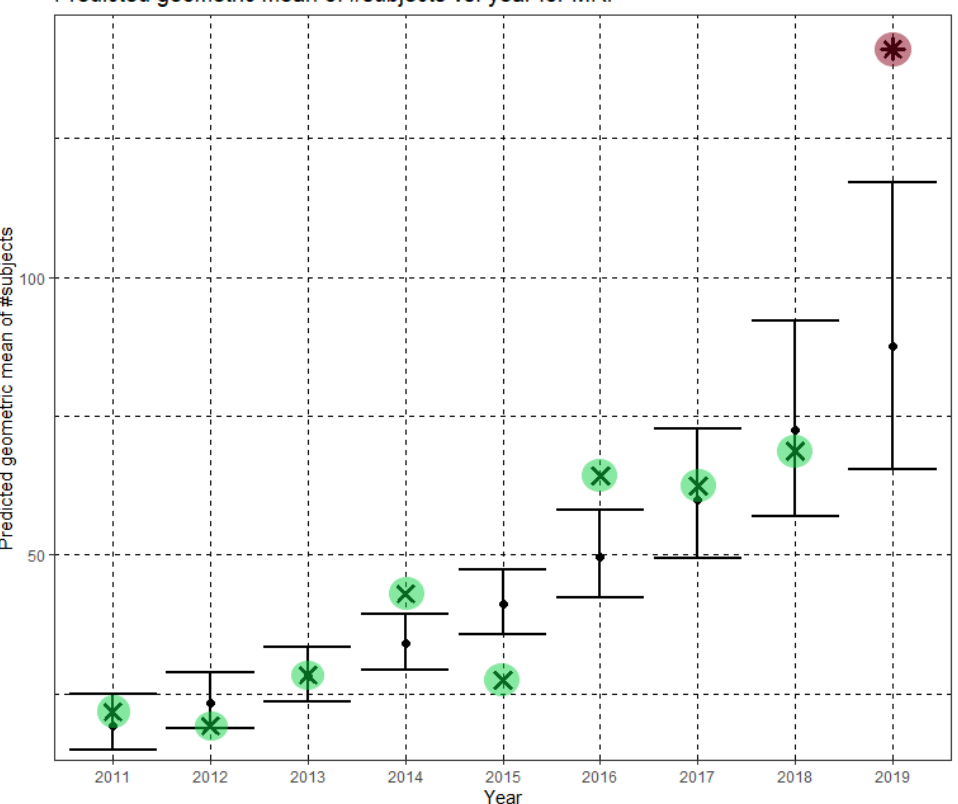
Figure 4. Phase I—Predicted geometric mean (black dots) and confidence intervals of dataset sizes in MICCAI articles involving MRI for the years 2011–2019, based on the whole ensemble of 2011–2018 MRI dataset sizes. The empirical geometric means (2011–2018) are shown (in green) for comparison (x marks). The empirical geometric mean for 2019 (in purple) became available later, in Phase II of this